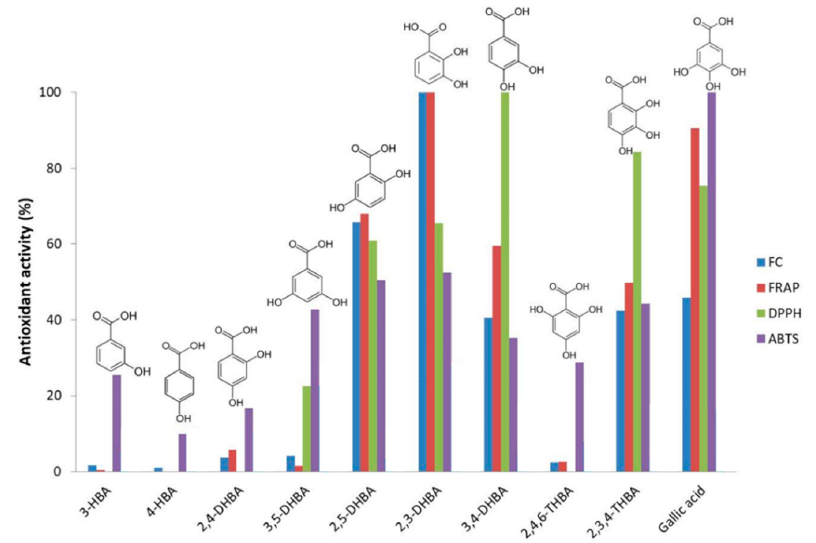
Figure 2. Comparison of antioxidant indexes for the series of hydroxybenzoic acids. Data corre- spond to the normalized slopes of the calibration curves of each analyte and each method. Com- pound assignation: 3-HBA, 3-hydroxybenzoic acid; 4-HBA, 4-hydroxybenzoic acid; 2,4-DHBA, 2,4-dihydroxybenzoic acid; 3,5-DHBA, 3,5-dihydroxybenzoic acid; 2,5-DHBA, 2,5-dihydroxybenzoic acid; 2,3-DHBA, 2,3-dihydroxybenzoic acid; 3,4-DHBA, 3,4-dihydroxybenzoic acid; 2,4,6-THBA, 2,4,6-trihydroxybenzoic acid; 2,3,4-THBA, 2,3,4-trihydroxybenzoic acid; gallic acid, 3,4,5-trihydroxybenzoic acid. Method assignation: FC, Folin–Ciocalteau; FRAP, ferric reducing antioxidant power; DPPH, 2,-diphenyl-1-picrylhydrazyl; ABTS, 2,2 ′ -azino-bis(3-ethylbenzothiazoline-6-sul- fonic acid)(adapted from reference [48]).